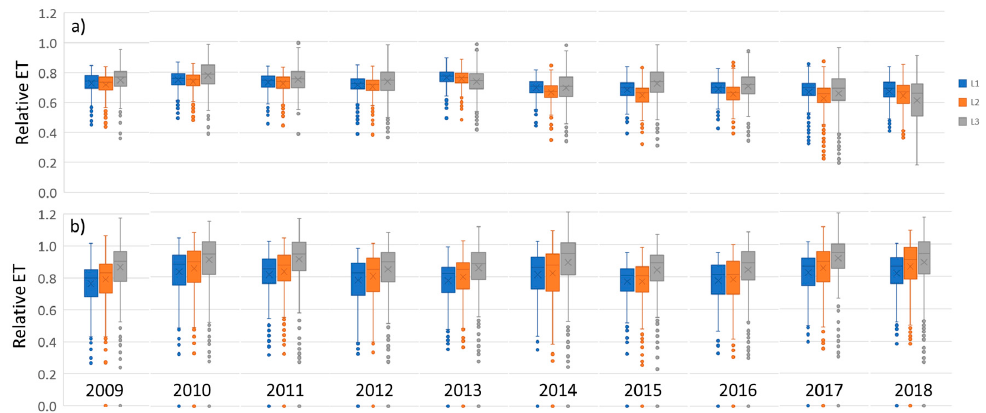
Figure 2. Box and whisker plot showing annual mean, quartiles and range relative ET of the ( a ) Wonji and ( b ) Metehara schemes for the L1, L2, and L3 resolutions.